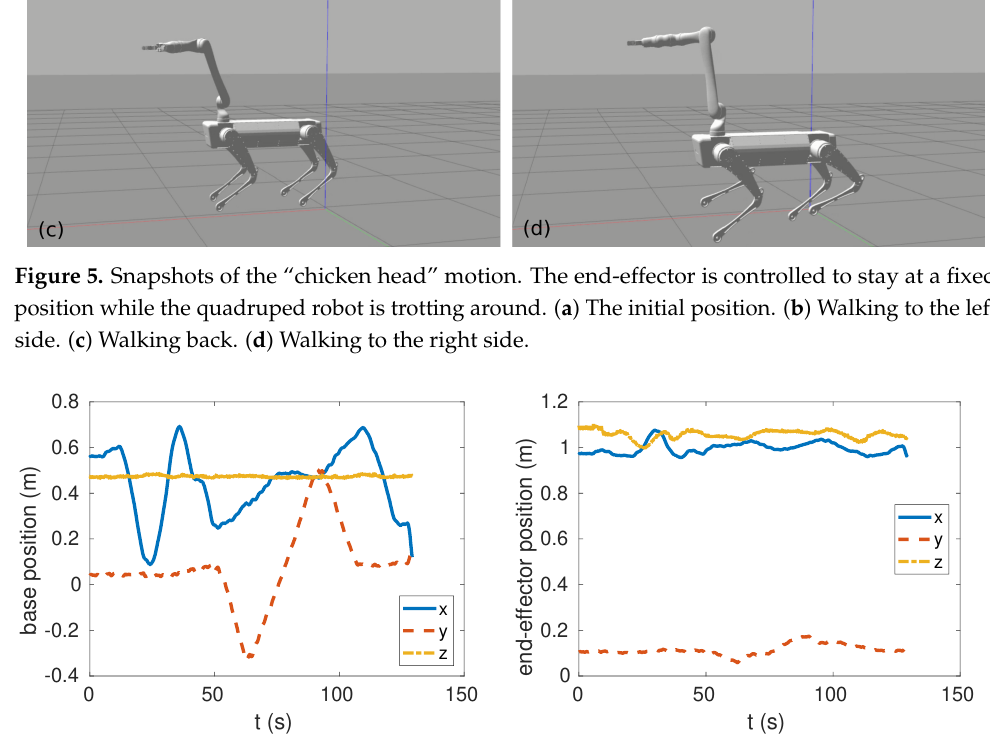
Figure 6. The recorded positions in world